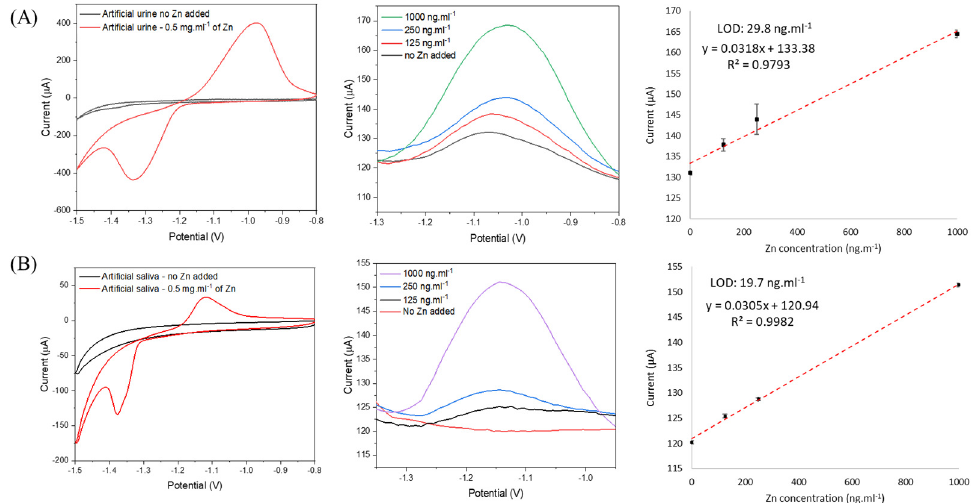
Figure 7. Salivary and urinary zinc quantification using zincon–modified CNT electrode. CV in absence and presence of zinc and SWV varying zinc concentration from 0 to 1000 ng · mL − 1 in artificial ( A ) urine and ( B ) saliva, respectively ( n = 3).